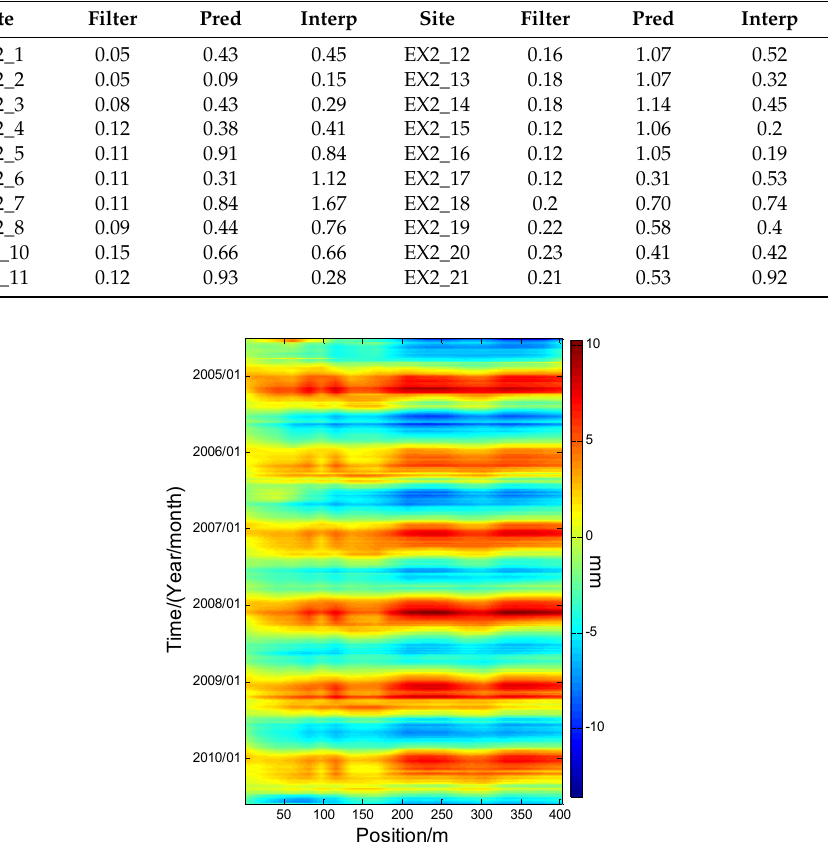
Table 3. RMS 2 Filter, Interpolation, and Prediction of each point (unit: mm). Interp, Interpolation; Pred, Prediction.